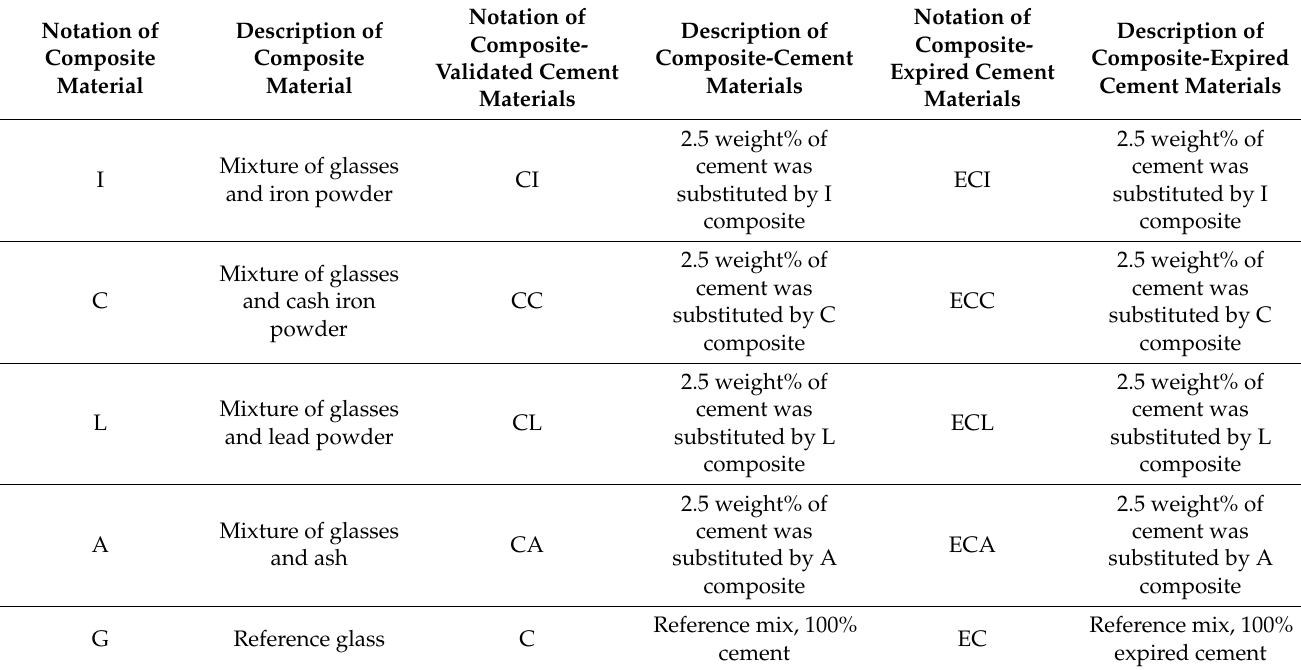
Table 1. Description of composite and composite-cement